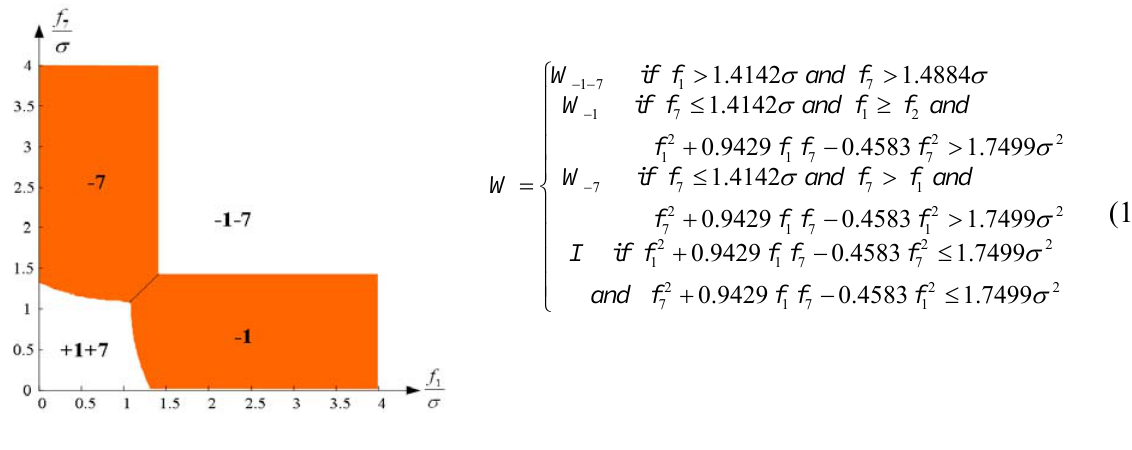
Figure 15. Accommodation rule for 1 st and 7 th faulty sensors for configuration